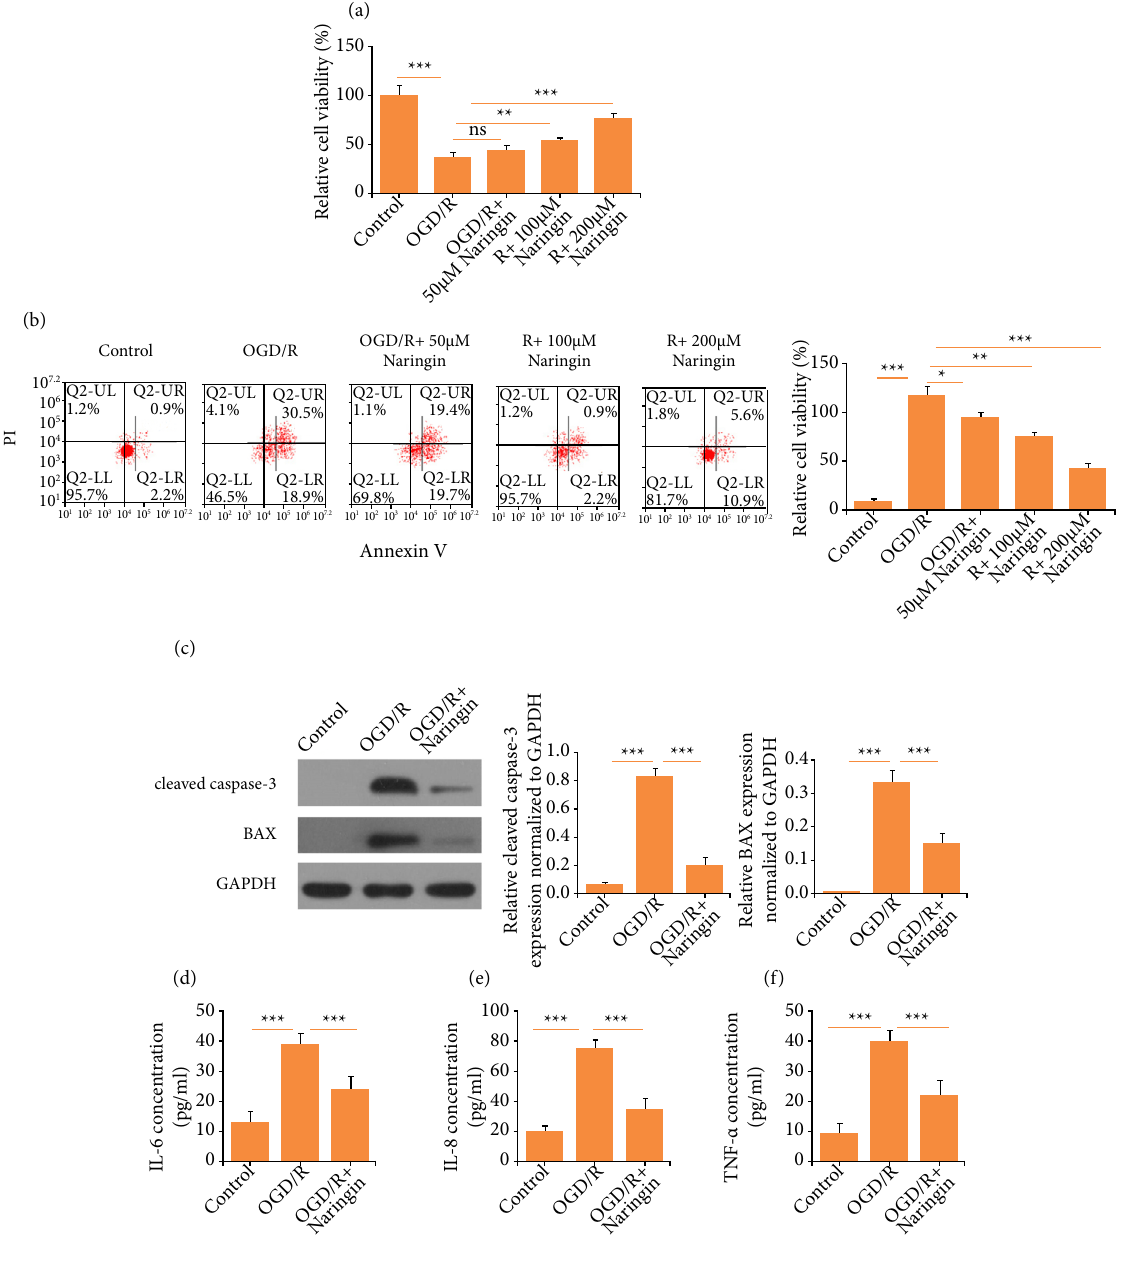
Figure 1 - Naringin reduces oxygen-glucose deprivation/recovery (OGD/R)-induced apoptosis and inflammation of cardiomyocytes. (a) Cell viability following OGD/R and/or naringin treatment. (b) Flow cytometry to detect cell apoptosis. (c) Western blots for cleaved caspase-3 and BAX. (d) IL-6 concentration. (e) IL-8 concentration. (f) TNF- α